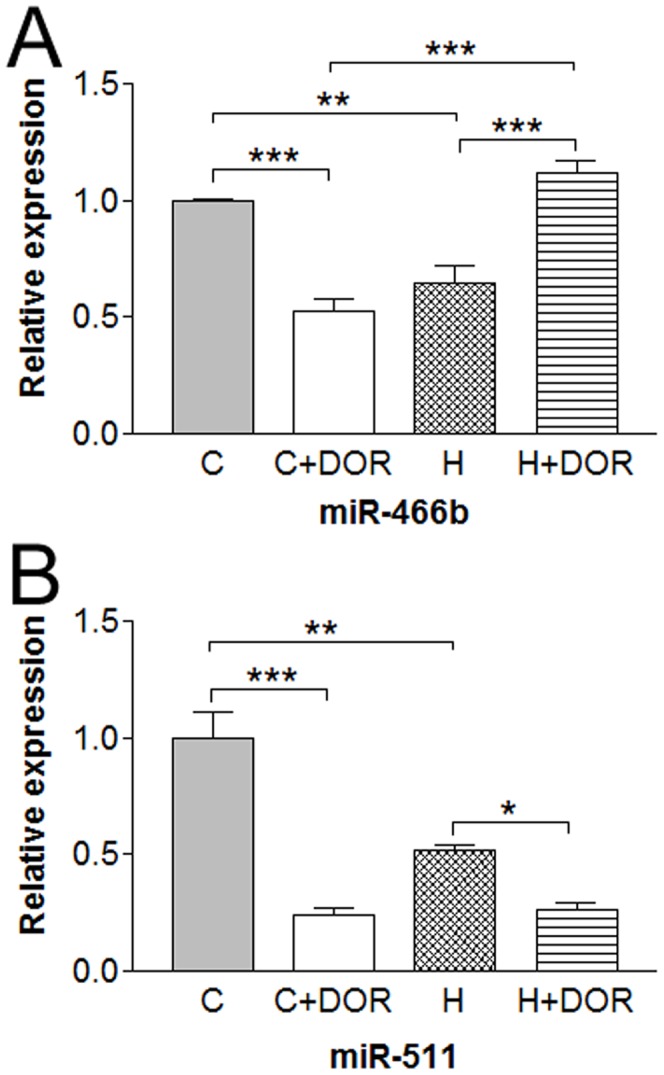
Relative miRNA expression levels of miR-466b and miR-511 in the kidney following 10 days of hypoxia as determined by quantitative RT-PCR.C, control; C+DOR, control+UFP-512; H, hypoxia; H+DOR, hypoxia+UFP-512. *p<0.05, **p<0.01, ***p<0.001.